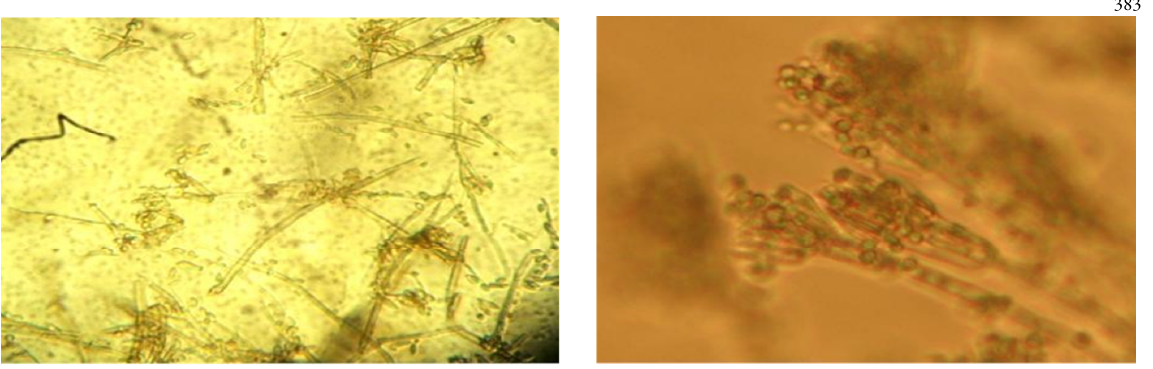
Fig. 3. Micrograph of Cladosporium sp. Fig. 4. Micrograph of Penicillium oxalicum